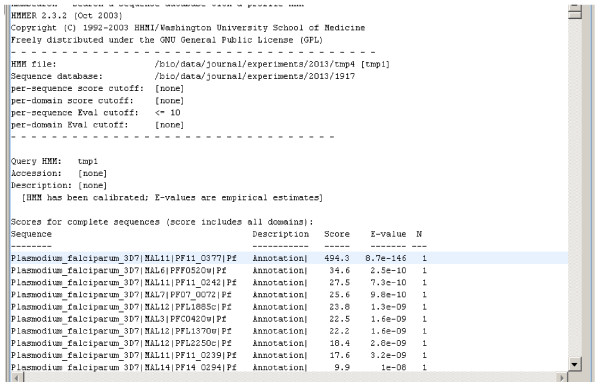
Experiment Results.